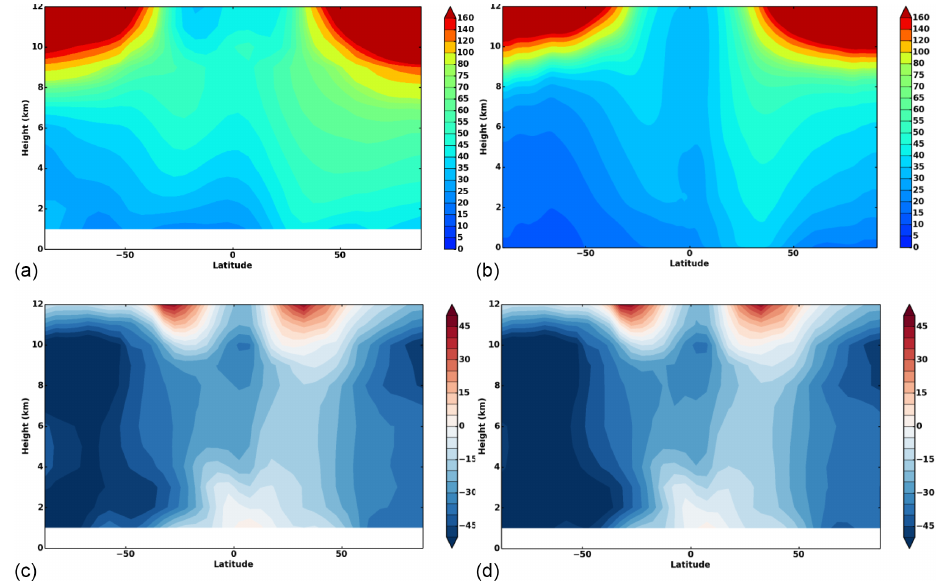
Figure 12. Zonal distribution of ozone concentration (ppbv) for the year 2006. (a) Observed distribution based on the global monthly mean vertical ozone profile database available from http://www.bodekerscientific.com; (b) the corresponding ACCESS-UKCA model distribution using the two-layer reactivity scheme; (c) the relative difference (%) between the modelled concentration determined using the two-layer reactivity scheme and the observations; and (d) the relative difference (%) between the modelled concentration determined using the default scheme and the